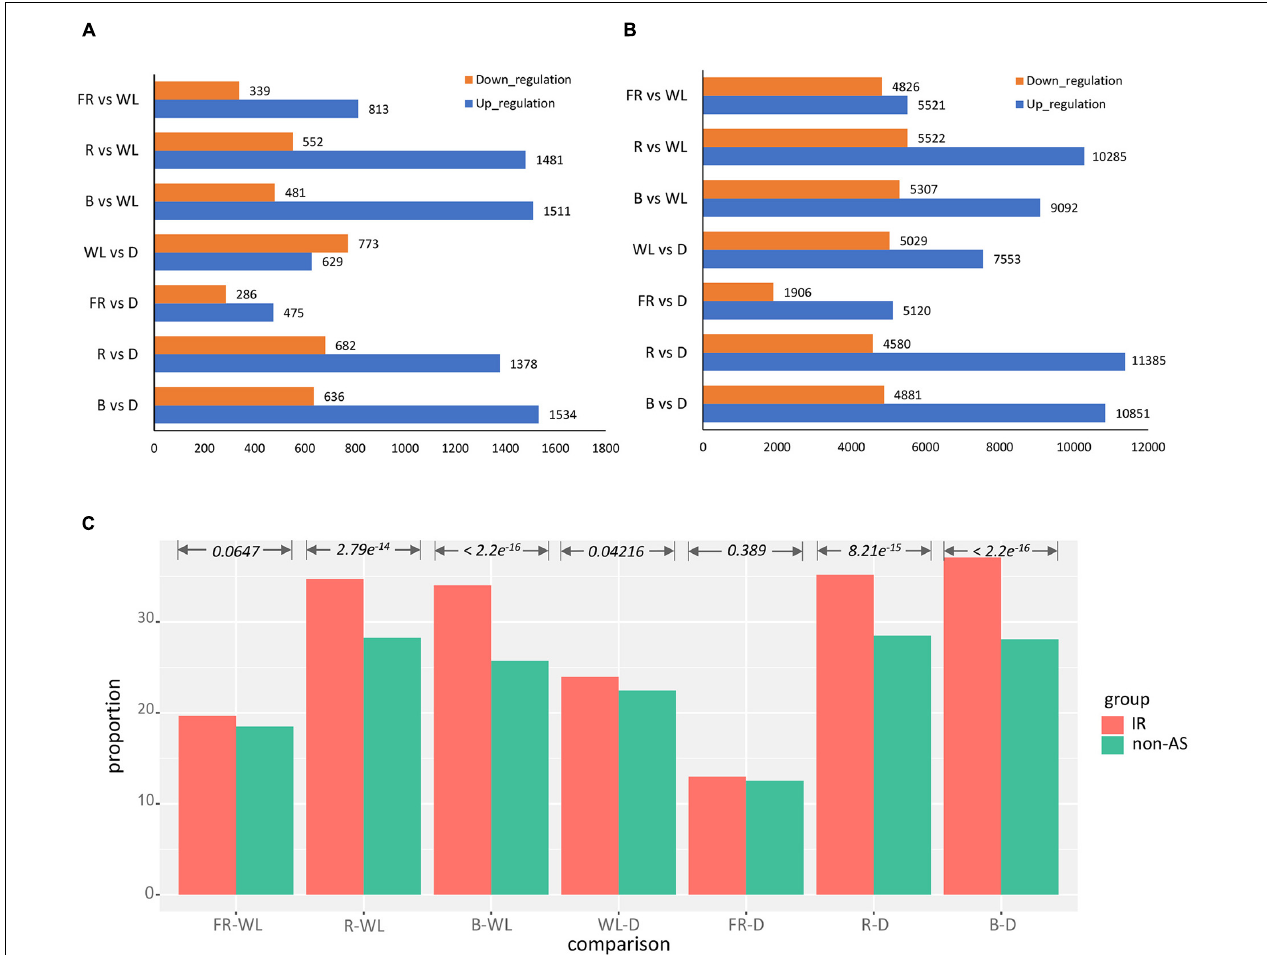
FIGURE 3 | Analysis of differential expression IR isoform expression pattern after light treatment. (A,B) Number of up- and down-regulated IR isoforms and non-AS genes after treatment, respectively. (C) Proportion of differentially expressed IR isoforms over all IR isoforms vs. the corresponding profortion of non-AS genes. B, blue light; R, red light; FR, far-red light; WL, white light; D, dark.